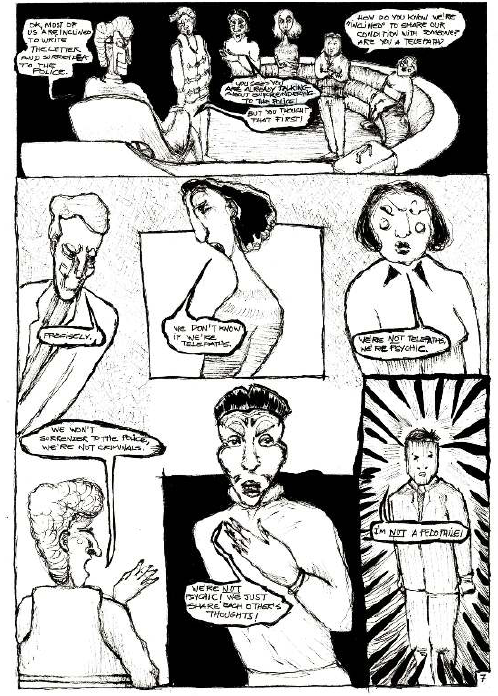
Credits: Amine Barbuda.